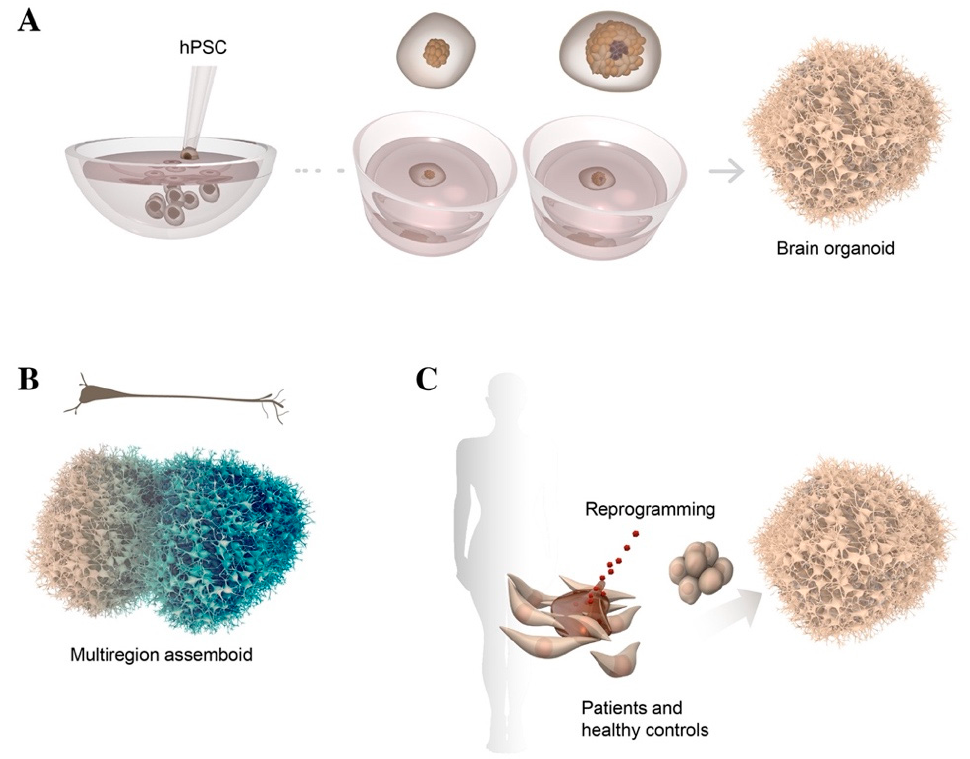
Figure 2. Schematic illustration of hPSC differentiation into human brain organoid using conic wells and Matrigel embedding ( A ). Representation of multiregion assembloid formed by the fusion of two distinct regionalized brain organoids; neurons mature and project over long distances, reaching their target structures ( B ). Somatic cells from healthy and PD patients reprogrammed into induced pluripotent stem cells and differentiated in brain organoid ( C ).